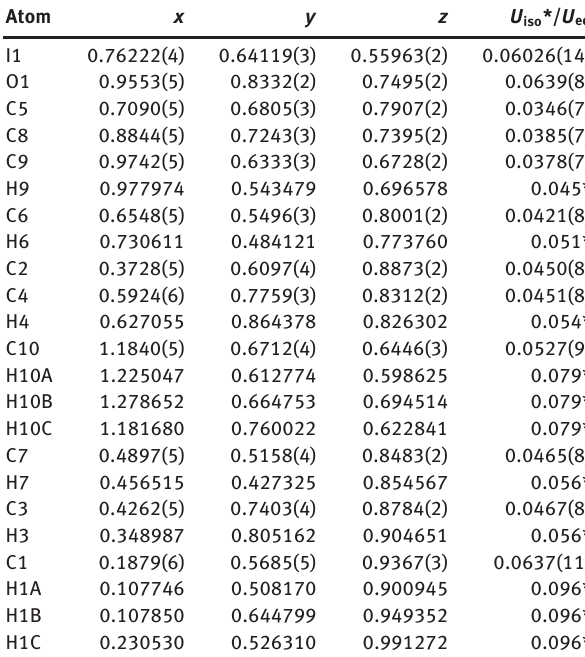
Table 2: Fractional atomic coordinates and isotropic or equivalent isotropic displacement parameters (Å 2